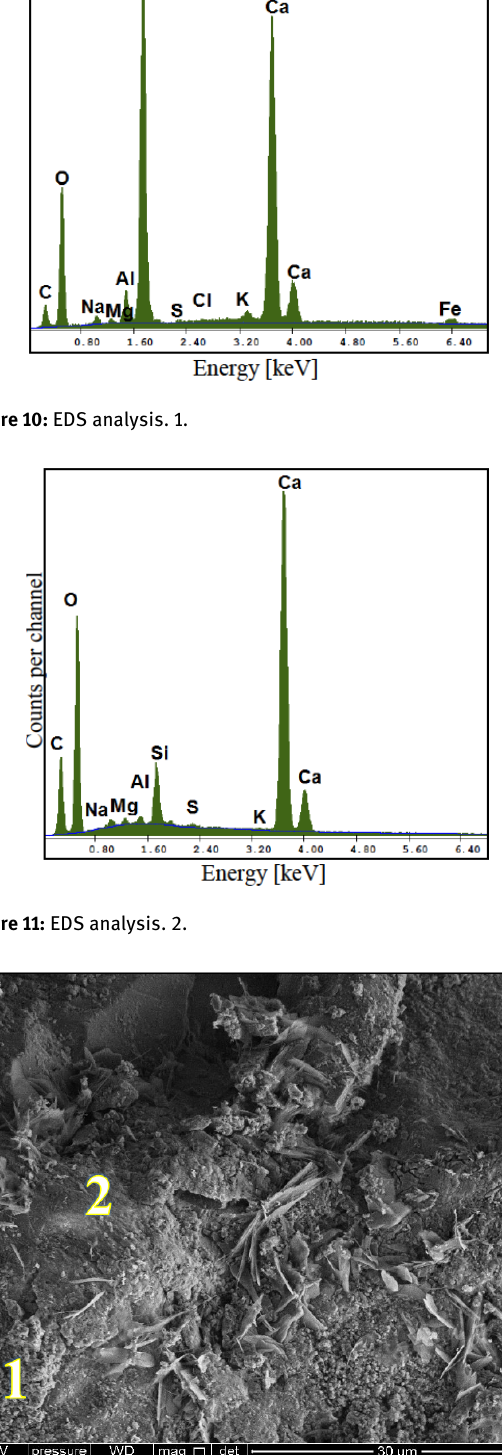
Figure 9: Microstucture of the reference product. 1. Tobermorite 2. C-S-H phase.